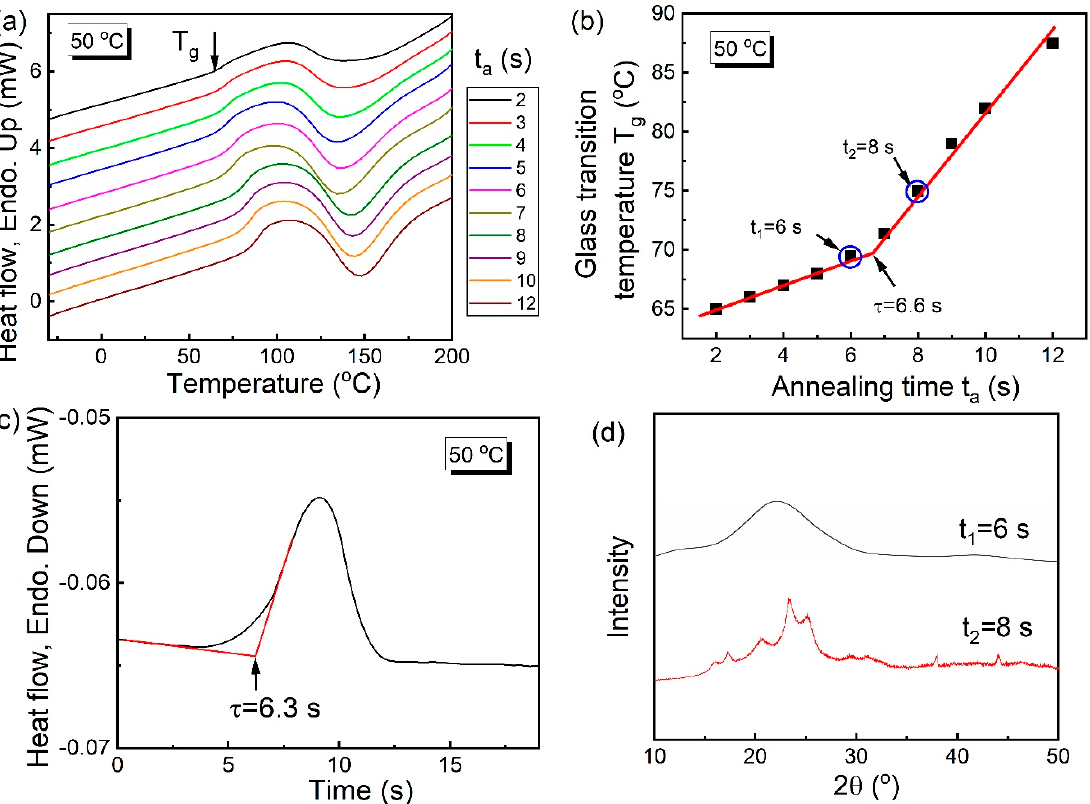
Figure 6. ( a ) A series of Flash DSC heat flow curves corresponding to different annealing times ranging t a from 2 to 12 s at 50 °C for amorphous PBT sample; ( b ) plot of T g and t a at 50 °C ( t 1 and t 2 are two selected annealing times before and after the break point of 6.6 s); ( c ) the isothermal test for PBT sample at 50 °C; and ( d ) XRD patterns for annealed samples corresponding to the annealing times of t 1 and t 2 .